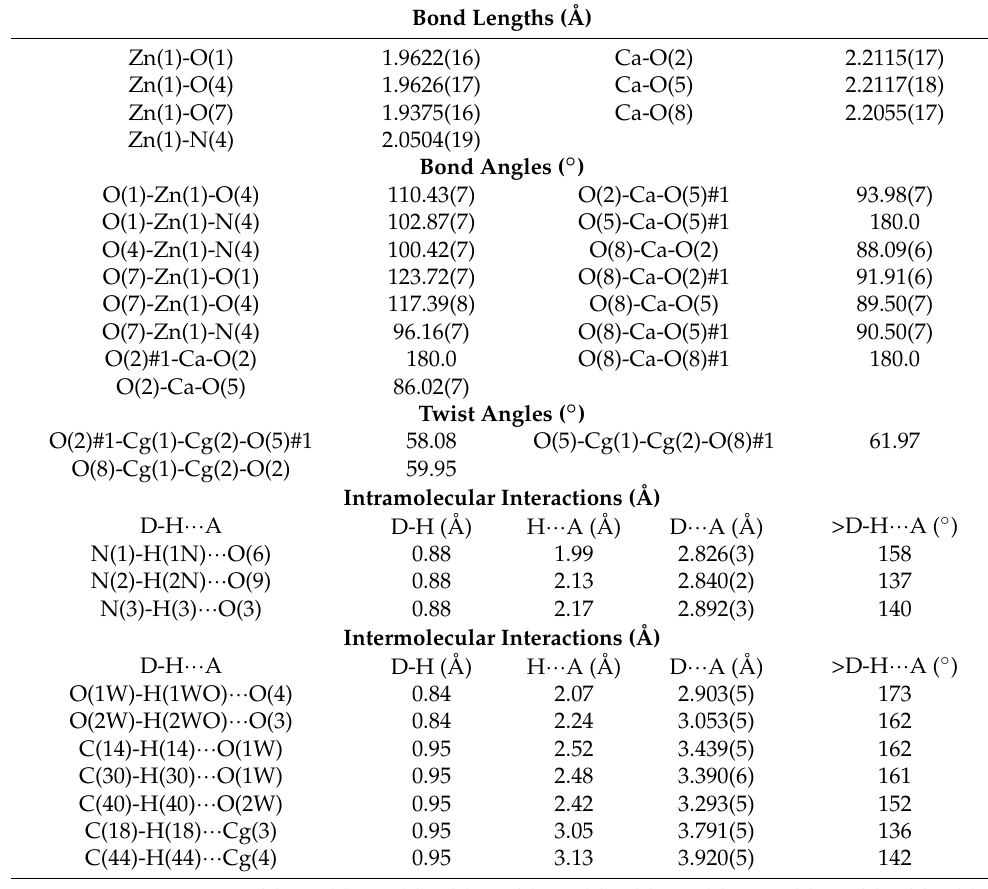
Table 2. Selected bond lengths (Å), bond angles ( ◦ ), intramolecular and intermolecular interactions (Å) for compound 1C